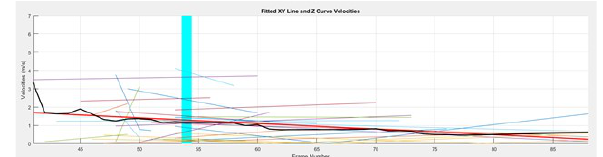
Figure 9. Progeny velocities plotted against frame